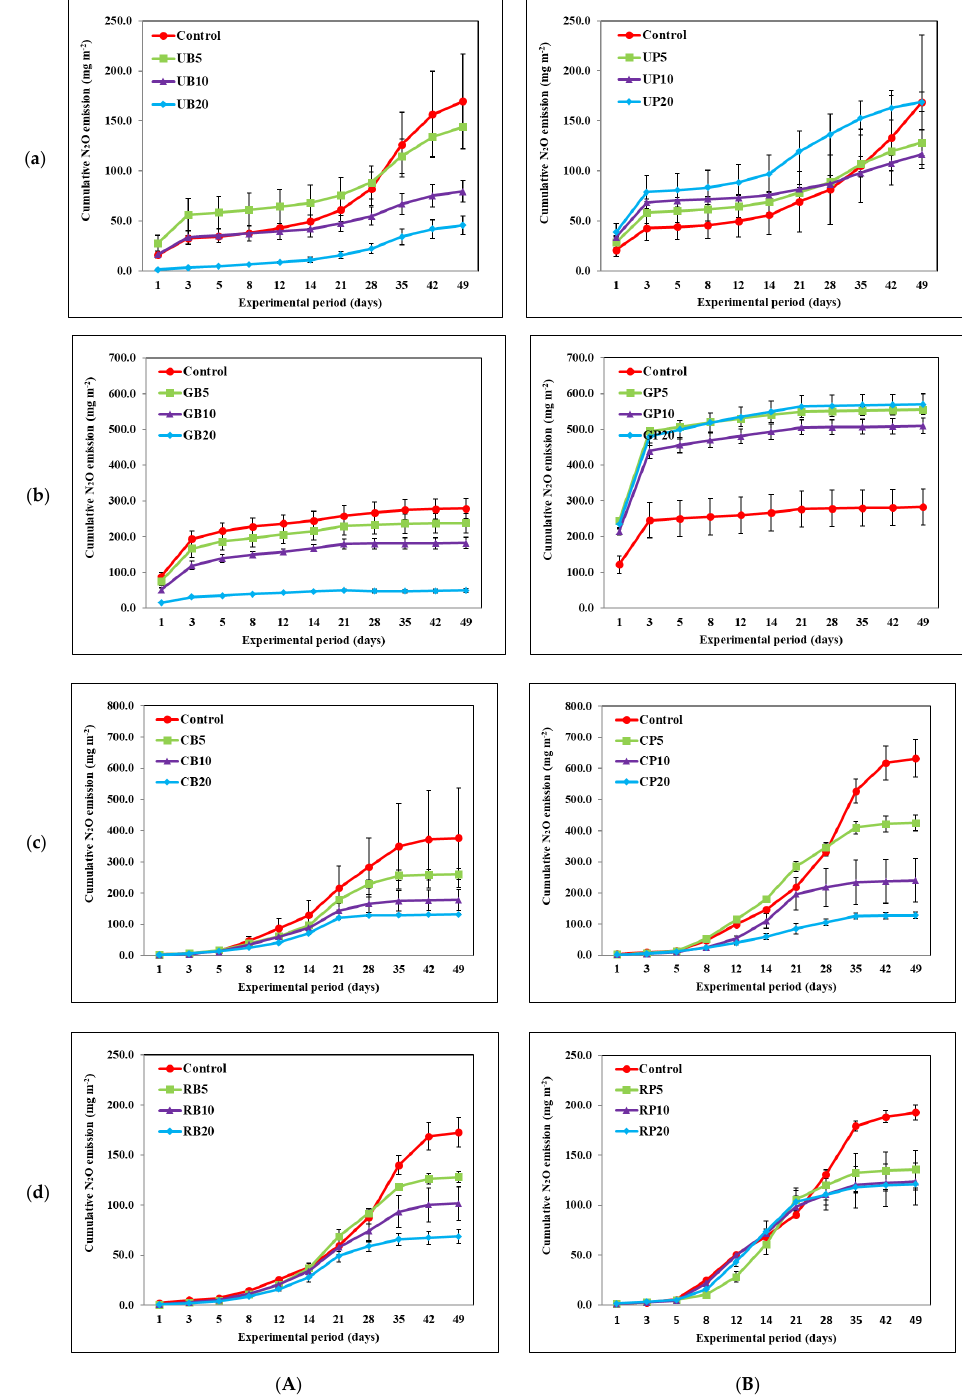
Figure 3. Cumulative N 2 O emission on biochar types and application rates according to soil charac- teristics under incubation conditions during the 49 days. The error bars represent standard errors (n = 3). ( a ): upland, ( b ): greenhouse, ( c ): converted land, ( d ): reclaimed land. ( A ) barley straw bio- char, ( B ) poultry manure biochar. In the greenhouses, N 2 O emissions were significantly reduced in the GB5, GB10, and GB20 experimental groups, but significantly increased in the GP5, GP10, and GP20 exper- imental groups. Compared with the control group, cumulative N 2 O emission in GB5,